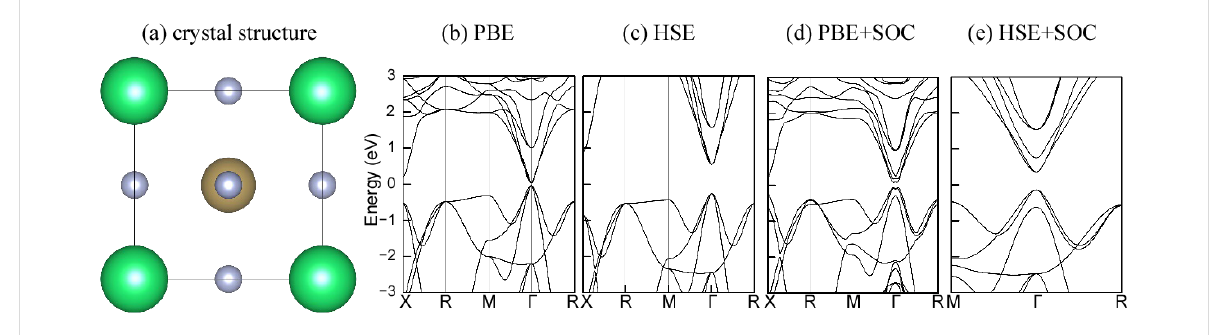
Figure 1: (a) Top view of ThTaN 3 with green, grey, and brown spheres representing Th, N, and Ta atoms, respectively. (b–e) The band structures of 3D cubic ThTaN 3 calculated by PBE, HSE, PBE+SOC, and HSE+SOC methods,